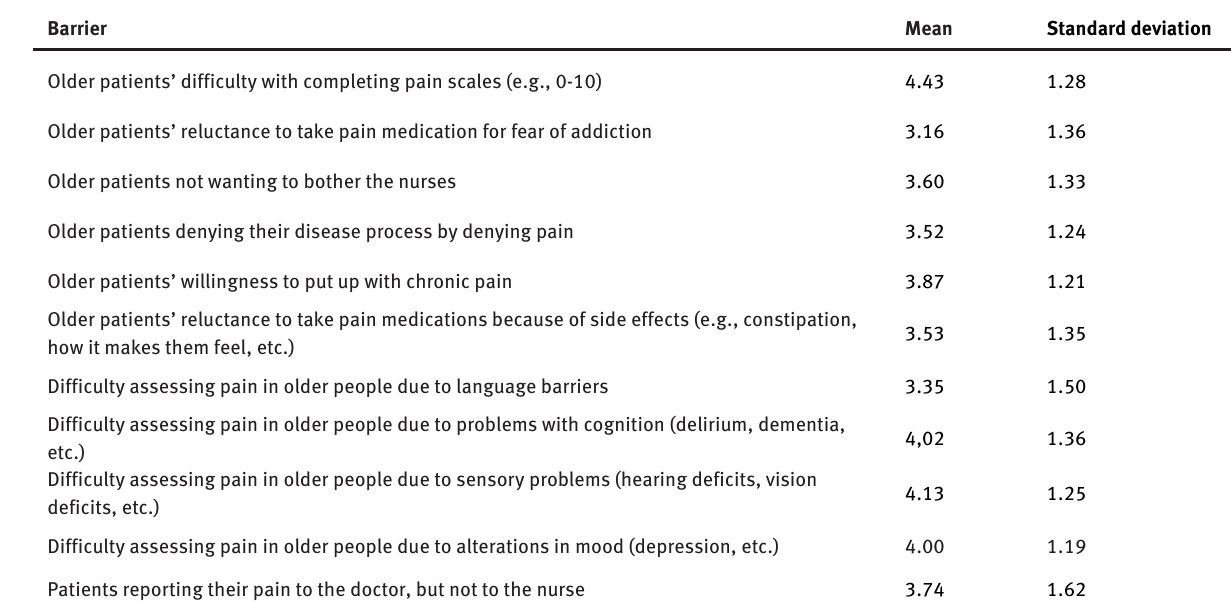
Table 5: Frequency characteristics of obstacles to optimal pain assessment and treatment in elderly patients, associated with the patients.